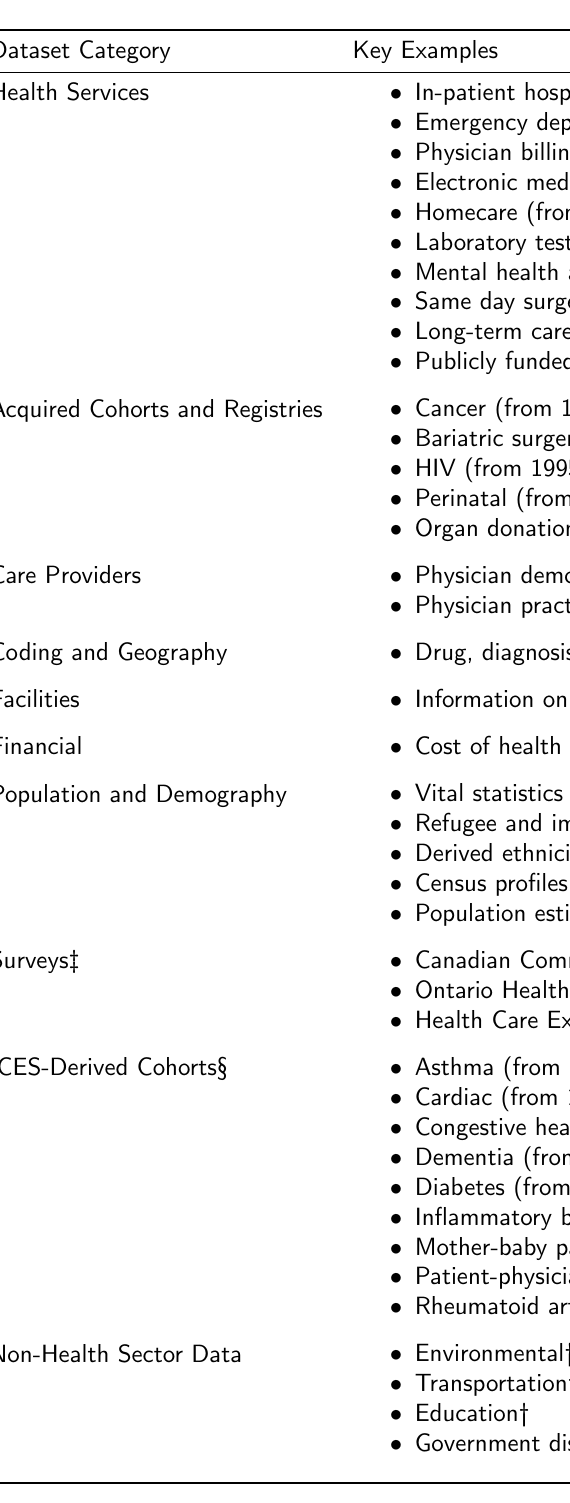
Table 1: Major Categories and Key Examples of Linkable Datasets Held at